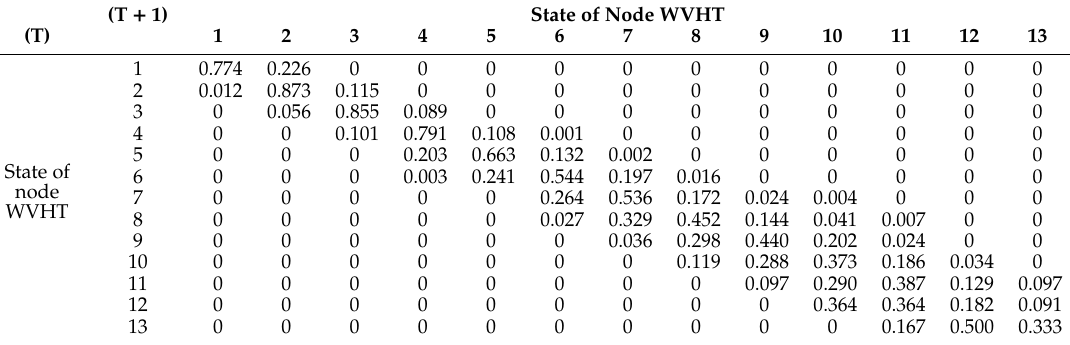
Table 7. The transition probability distribution of node WVHT.